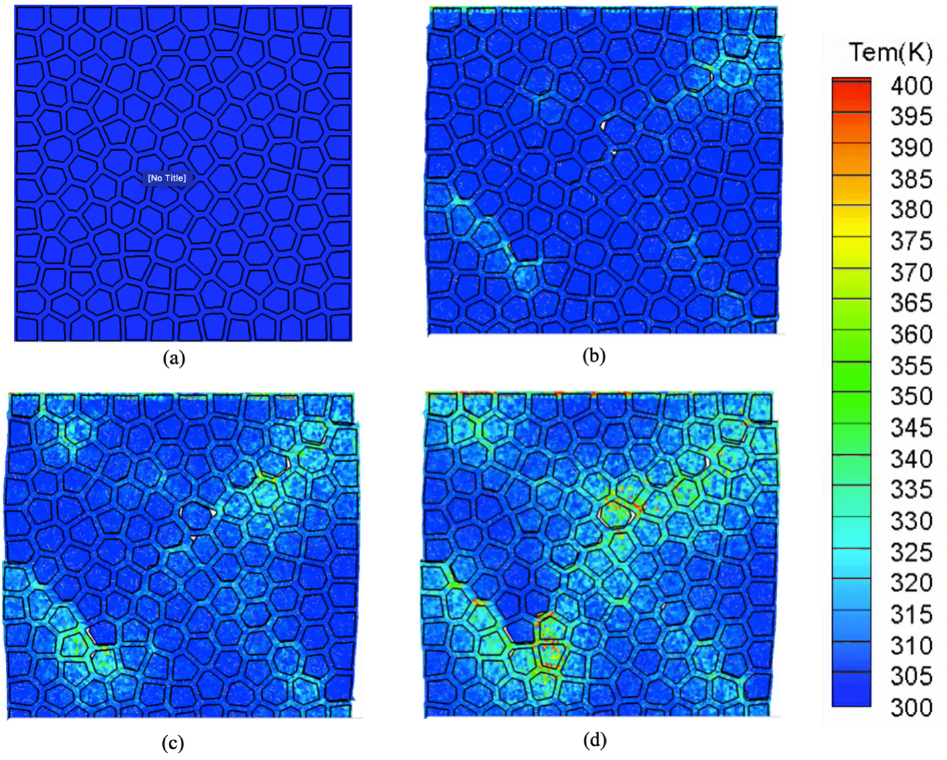
Figure 4. Snapshots of temperature distribution in specimen:( a ) initial stage; ( b ) crack initiation; ( c ) crack propagation; ( d ) final stage. As loading increases, the hot-spot was generated at the damaged interface between grain and